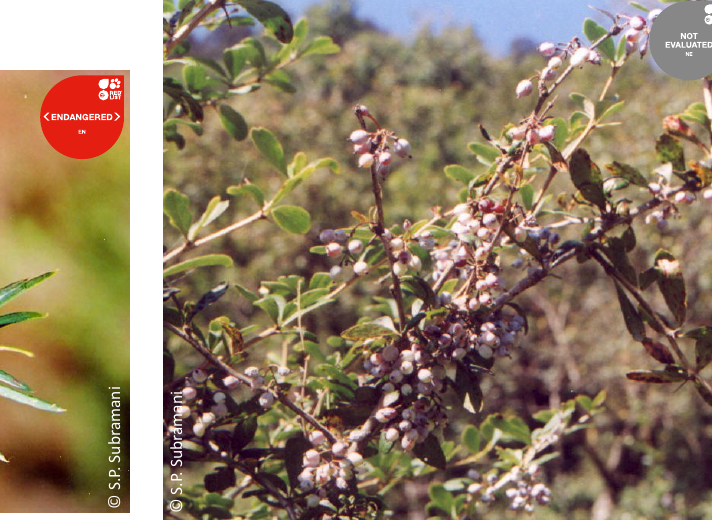
Image 31. Taxus wallichiana Zucc. Image 32. Berberis aristata